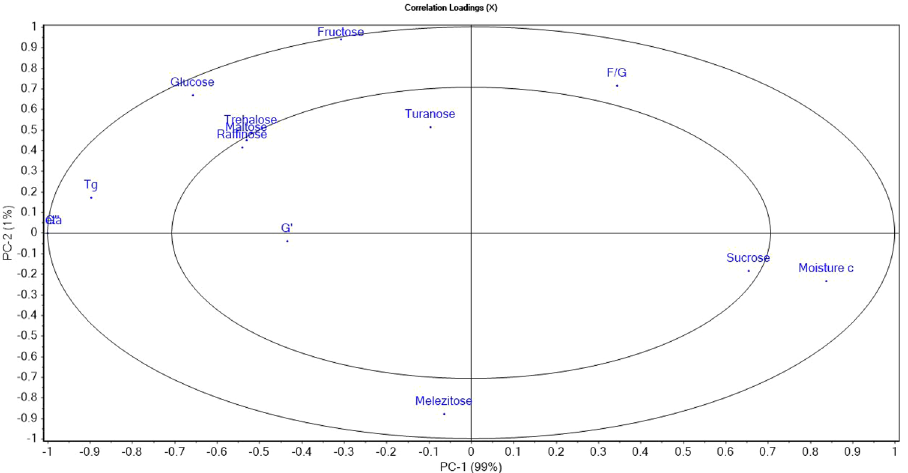
Figure 6. Principal component analysis loadings of the parameters